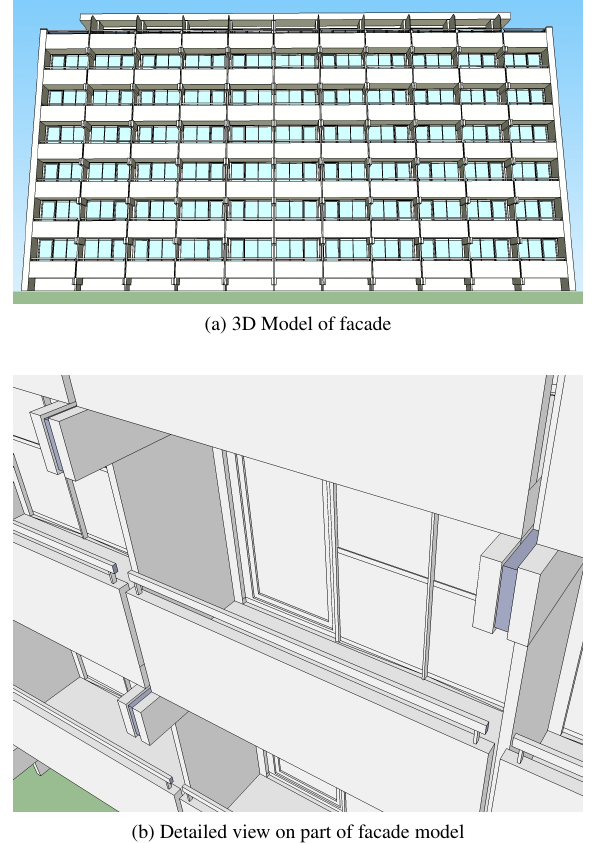
Figure 3: Overview on the 3D model of the facade located at Marsstrasse (top). Several constructional details are included that can be seen from a slight side view